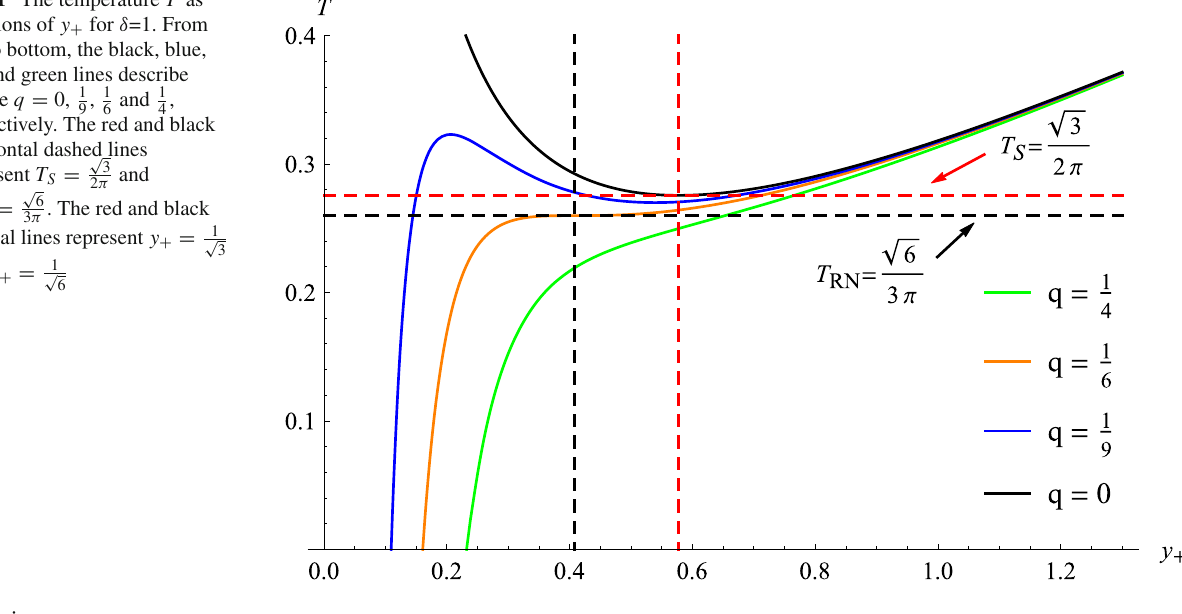
Fig. 1 The temperature T as functions of y + for δ =1. From top to bottom, the black, blue, red and green lines describe charge q = 0, 1 , 1 and 1 , 9 6 4 respectively. The red and black horizontal dashed lines √ 3 represent T S = and 2 π √ 6 T RN = . The red and black 3 π vertical lines represent y + = 1 √ 3 and y + = 1 √